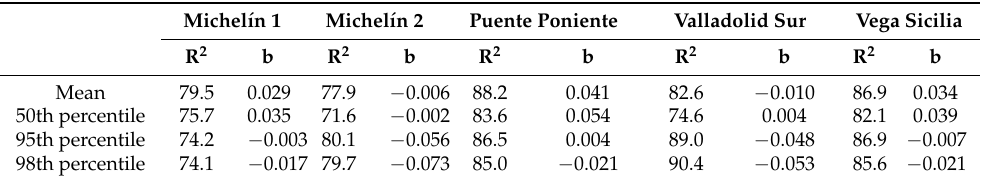
Table 7. Coefficients of determination (%) and b ( µ g m − 3 month − 1 ) of the multiple regression fit in the study period for each measuring station.